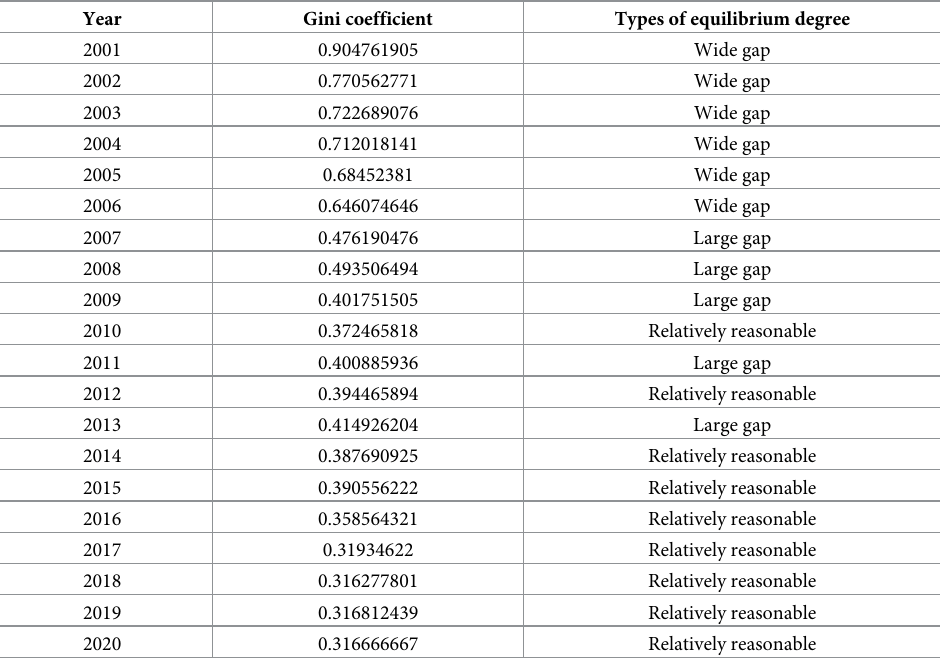
Table 2. Grading results of Gini